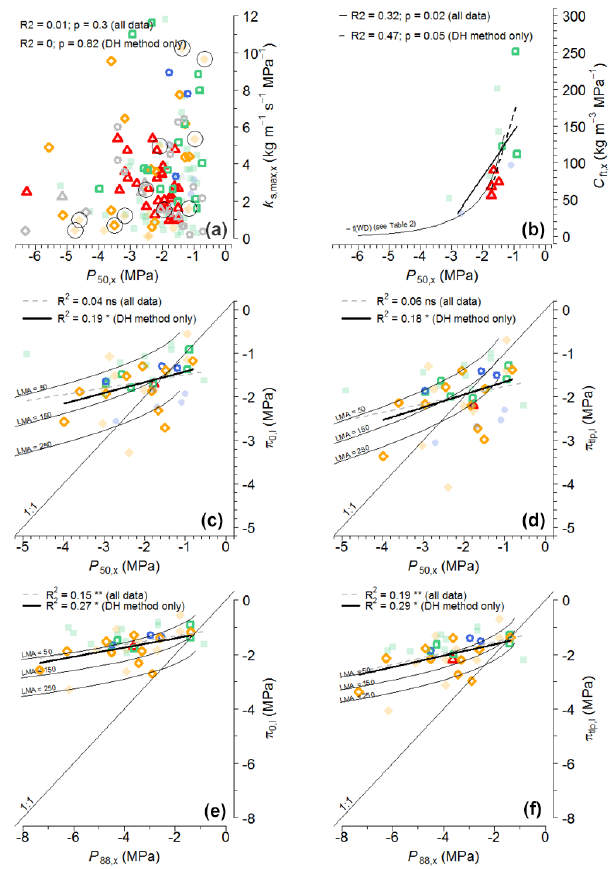
Figure 8. Tropical synthesis of trade-offs or coordination of vari- ous hydraulic traits with the water potential at 50 or 88% loss of maximum xylem conductivity ( P 50,x or P 88,x ) . (a) The relationship between maximum xylem conductivity ( k s,max,x ) and P 50,x does not support the notion of a trade-off between xylem efficiency and safety, except in tropical dry forests (circled points). (b) The rela- tionship between xylem capacitance ( C ft ) and P 50 provides tenta- tive evidence for a trade-off between drought avoidance and toler- ance. (c–f) Relationships of the leaf osmotic potential at full turgor ( π o , l ) and the leaf turgor loss point ( π tlp,l ) with P 88,x support the hypothesis of coordination between leaf and xylem drought resis- tance, with less support for the hypothesis in terms of P 50,x . Thin lines in panels (b–f) correspond to the empirical equations in Ta- ble 2 over a wide range of input WD [0.2, 1.2] and LMA [50, 250]. Symbols are the same as in Fig. 4. See Supplement Fig. S2.3 for a version of panel (b) in which no correction factor was applied to sapwood PV curves. Asterisk codes for significance are the same as in Fig.